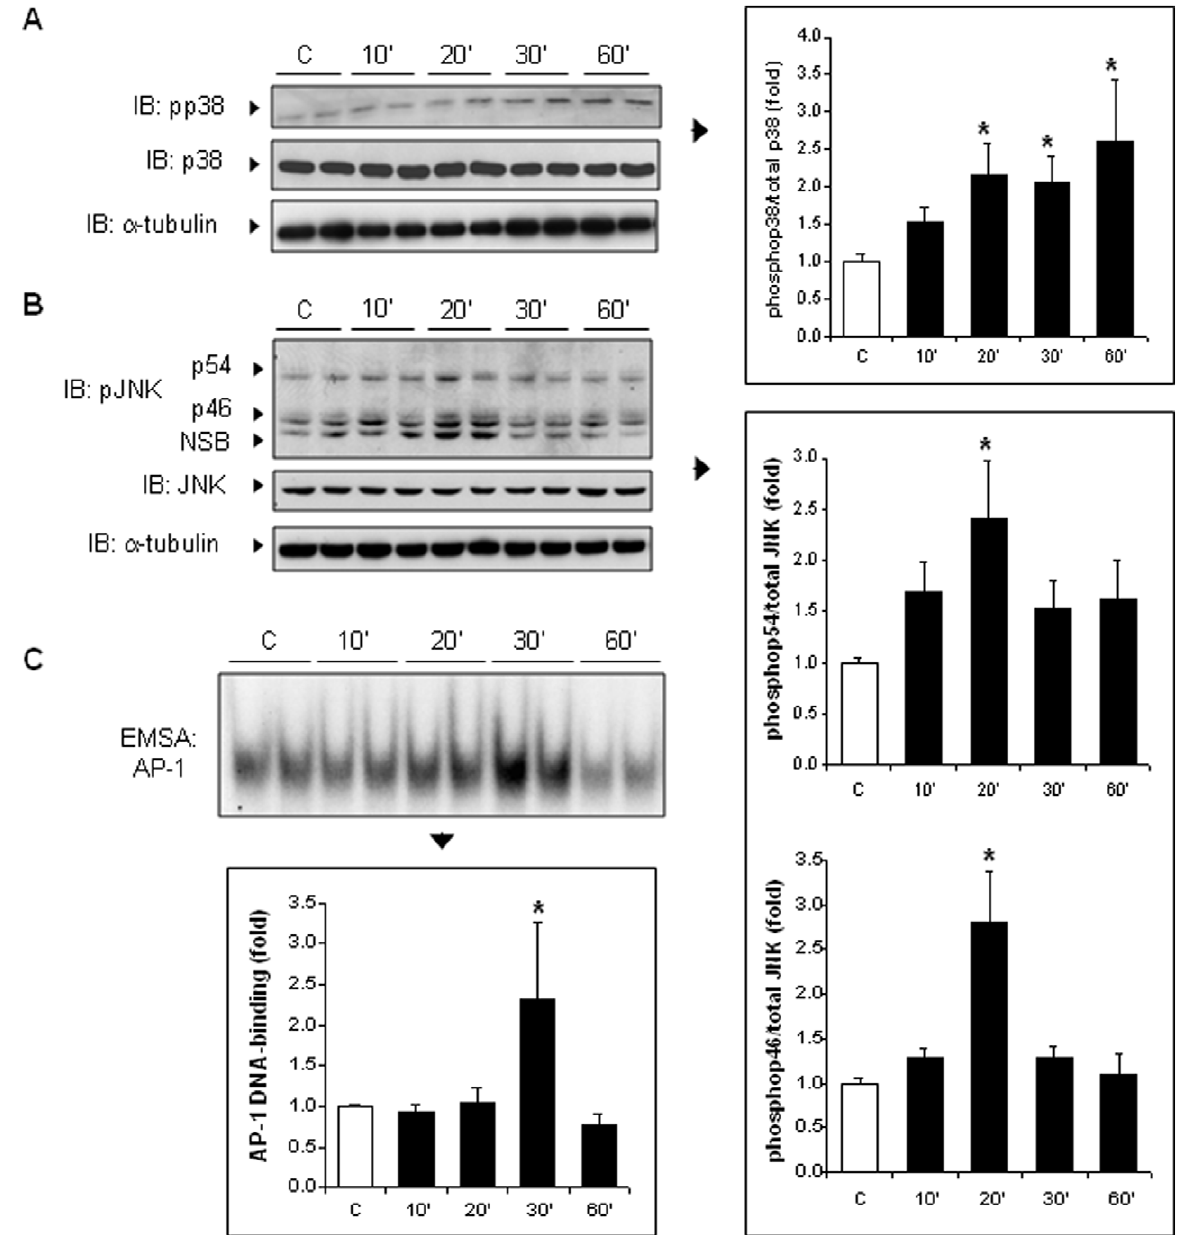
Figure 5. Flagellin activates MAP kinase signaling in H9c2 cells. A, Flagellin induced p38 phosphorylation from 20 to 60 minutes. Total p38 remained unchanged. B, Phosphorylation of JNK was triggered by flagellin after 20 minutes. Total JNK1 remained unchanged. C, Flagellin triggered AP-1-DNA binding activity with a peak at 30 minutes. NSB: non-specific band. * p , 0.05 versus control C (ANOVA followed by Dunnett test).